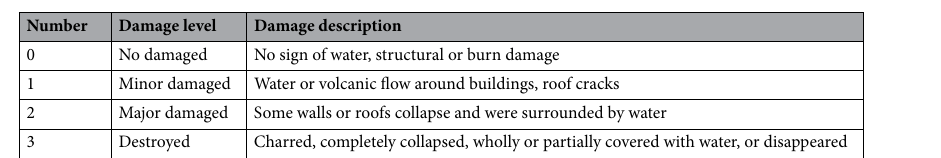
Table 1. Damage level and damage description.